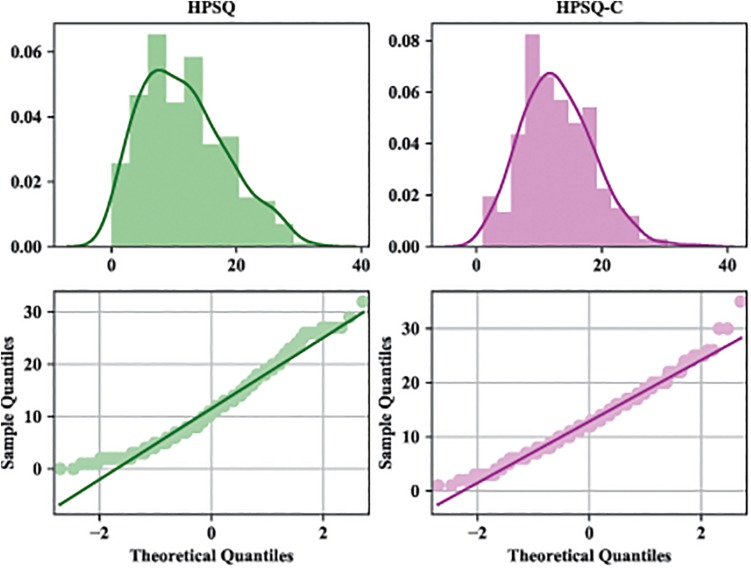
Kernel density estimation, histogram, and Q–Q plot of HPSQ/HPSQ-C total score.